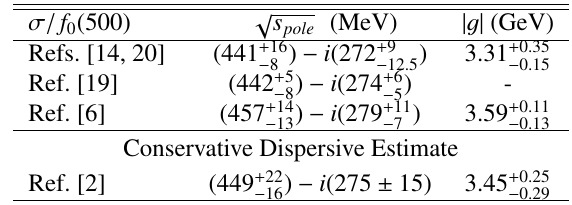
Table 1. σ/ f 0 (500) pole determinations using Roy or GKPY equations and the conservative dispersive estimate [2] which covers them. For the latter we have corrected a typo in the error of Im read ± 12MeV instead of ± 15MeV.